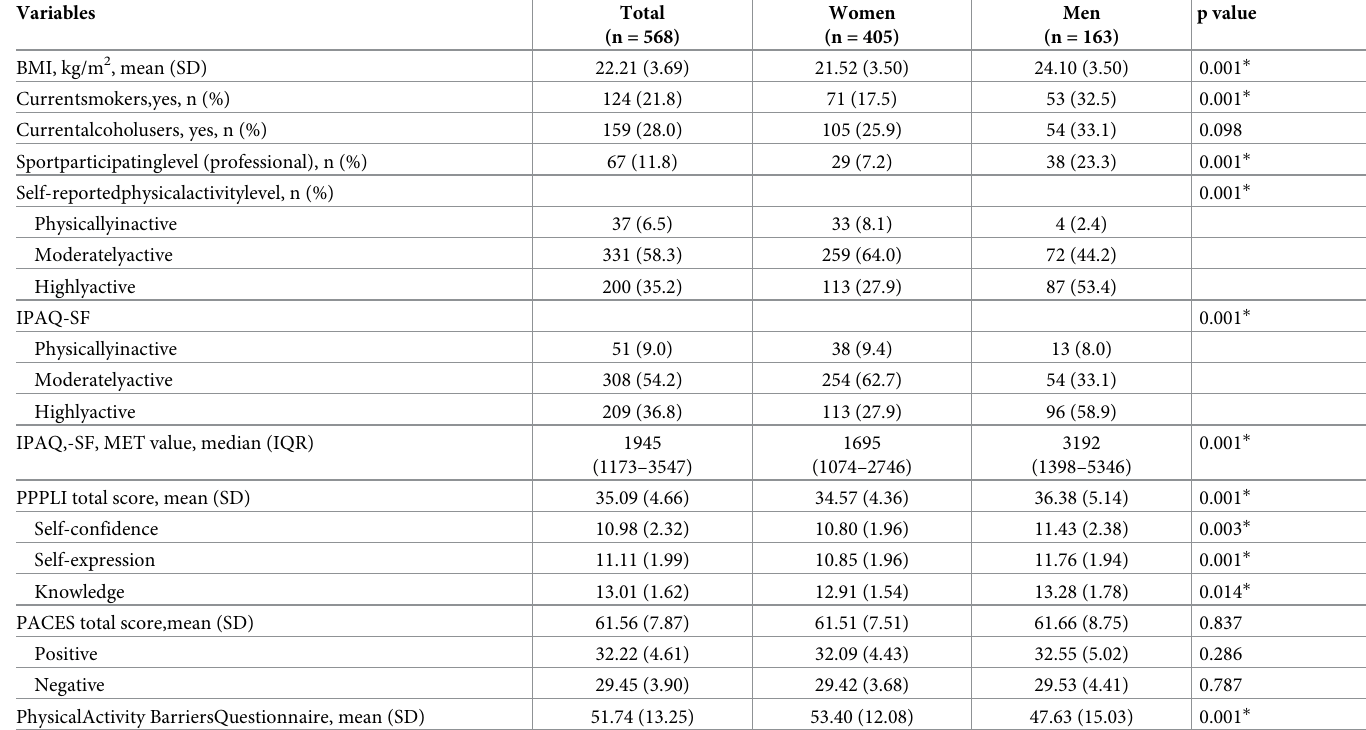
Table 1. The characteristics of participants stratified by gender.